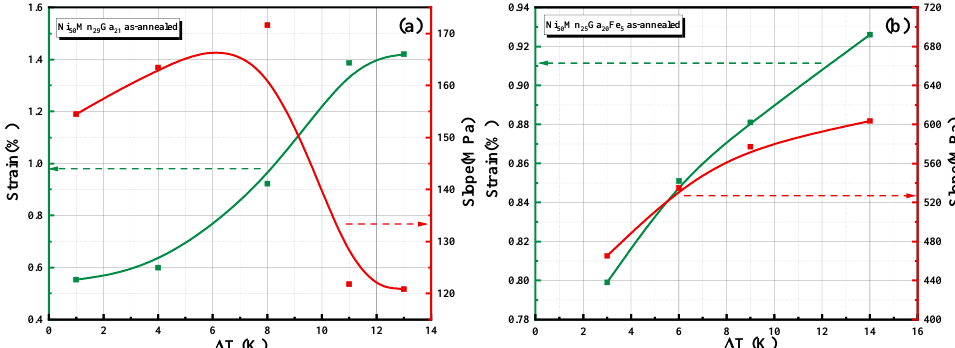
Figure 7. ( a ) Relationship curves between elastic strain, elastic modulus and temperature difference for Ni 50 Mn 29 Ga 21 microwire, ( b ) Relationship curves between elastic strain, elastic modulus and temperature difference for Ni 50 Mn 25 Ga 20 Fe 5 .